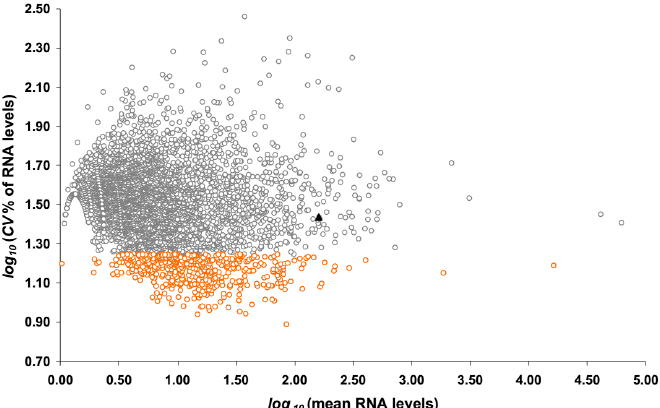
Figure 1. The coefficient of variation ×100% ( CV )% and mean of RNA expression levels of gene exons across all maternal blood samples based on RNA-sequencing (RNA-seq). Each datapoint represents an exon. Shown are 4579 exons that are robustly detected (minimum RNA level across all samples >0 count). RNA levels are calculated by normalized read counts mapping to each exon. Highlighted in the orange circles are 458 exons with a CV % in the lowest 10th percentile. The black triangle shows the data from the GAPDH transcript.